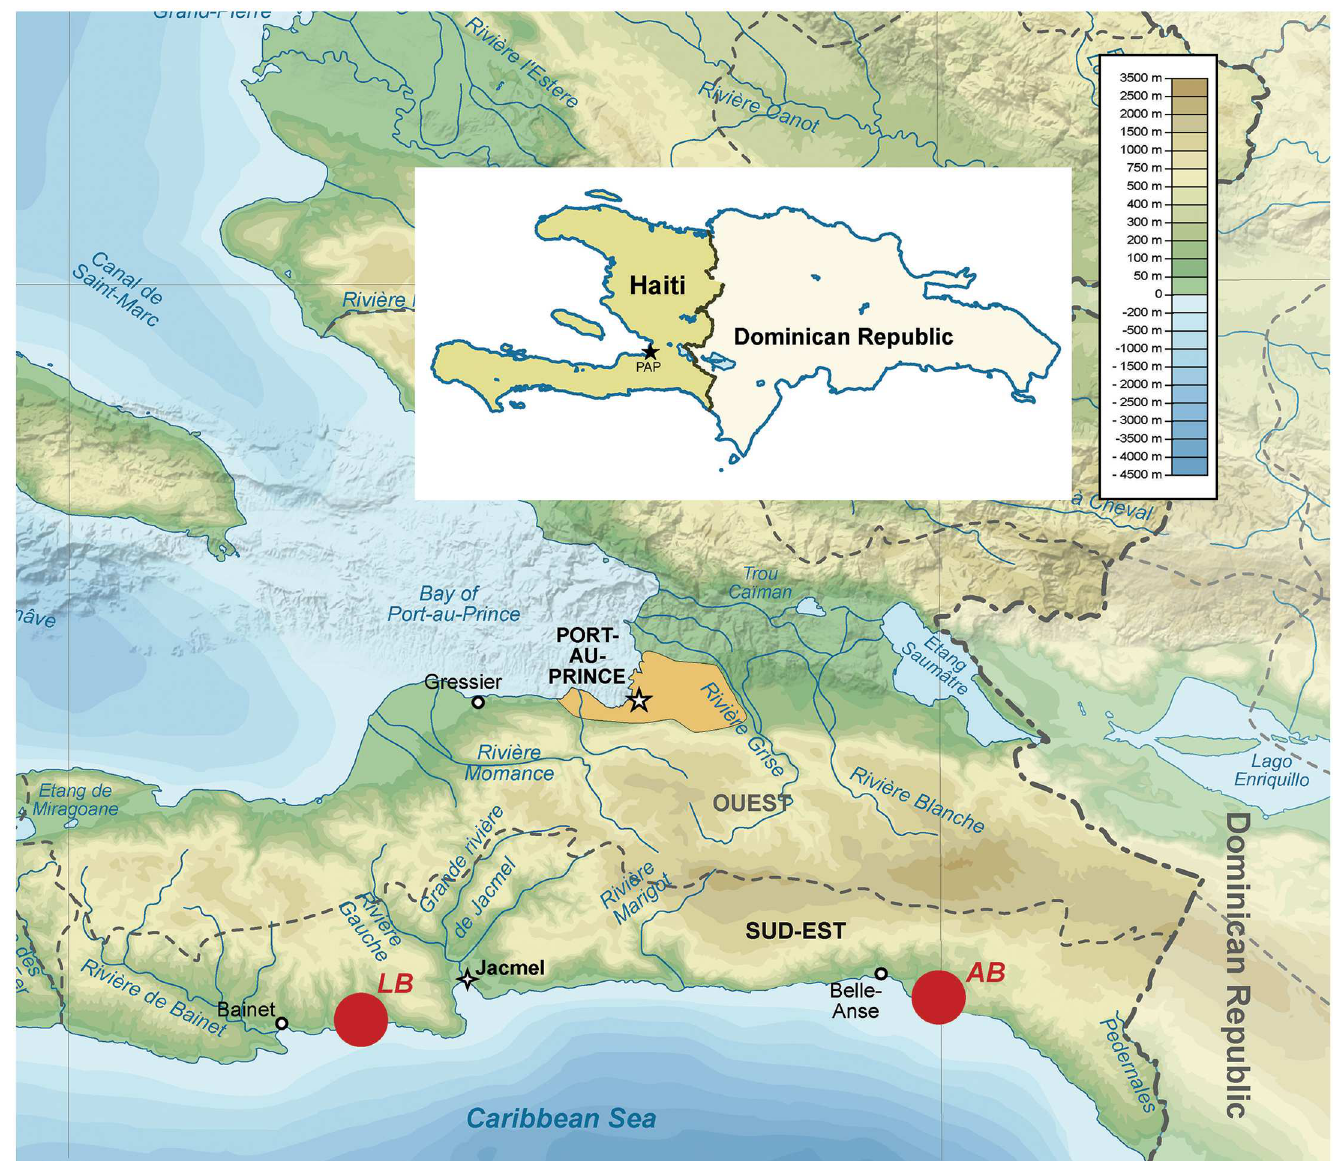
Fig 1. Map of the department of Sud-Est Haiti displaying sites of asymptomaticand symptomatic malaria patients were collected. Map of the Department of Sud-Est, Haiti with clinical sites La Bre´silienne(LB) and Anse à Boeuf (AB) where individuals’ samples were collected from these two respectivevillages.The two sites were over 70 km apart in distance, and had poorly traversable roads betweenthe two villages.Map of the island of Hispaniola(insert) displayingthe two countriesHaiti and the DominicanRepublicis included. A topographicscale is provided for reference purposes. Maps were providedby Wikipediaand WikimediaCommons, and were modifiedto displaysample sites accurately.